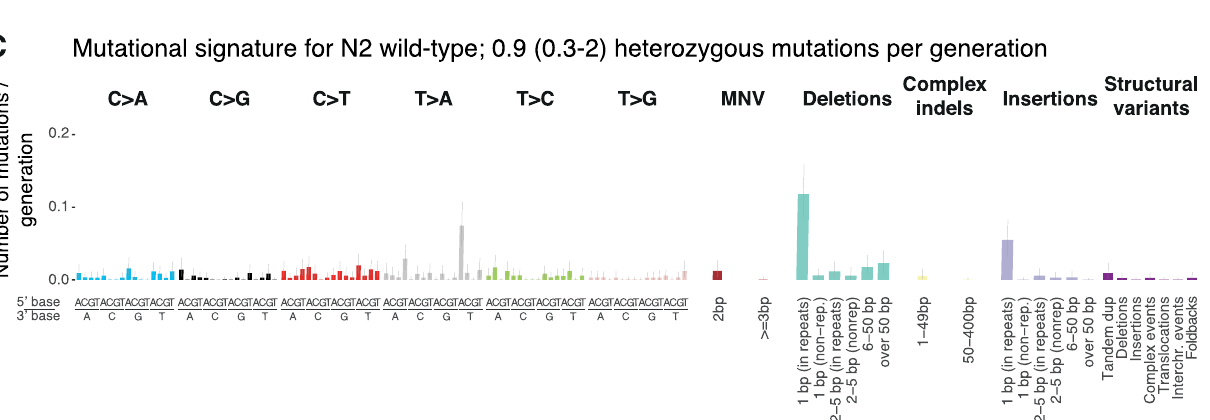
Fig 1. Experimental outline and background mutagenesis in wild-type. A. L4 larvae (F1 generation) from a parental founder strain (P0) were individually picked onto NGM plates and allowed to self-fertilize prior to picking individual L4 larvae of the next generation (F2) from each F1 plate. This process was repeated until clonal lines reached generation F20 or F40. Clonal lines were then allowed to expand, harvested, and prepared for whole genome sequencing (Materials and Methods). B. Mutation types and their location on the 6 C . elegans chromosomes (I-V and X) across all wild-type samples and mutation classes. The height of the white bars corresponds to the length of the respective C . elegans chromosome. Single nucleotide variants are indicated by a dot, dinucleotide variants (DNVs) by a square, indels divided in deletions (D) and insertions (I) by a triangle, and structural variants (SVs) by a line. C. Average number of heterozygous mutations in the N2 wild-type genome per generation across all mutation classes and types. Single nucleotide variants are shown in the context of their 5’ and 3’ base. Grey bars denote 95% credible intervals for the number of mutations in each type. “Complex indels” class denotes deletions with insertions. Data for N2 was previously shown in ([10] Fig 1C) . Information related to the 528 whole genome sequencing WGS primary-source datasets (56 deposited in this study, 472 deposited in (Suppl Data 1 and Supple Note 1 of [10] can be found in S1 Table).